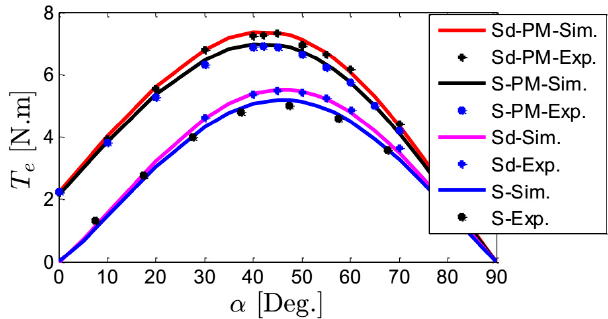
Figure 22. The output torque ( T e ) of the four SynRMs as a function of the current angle ( α ) at half-rated current and speed.